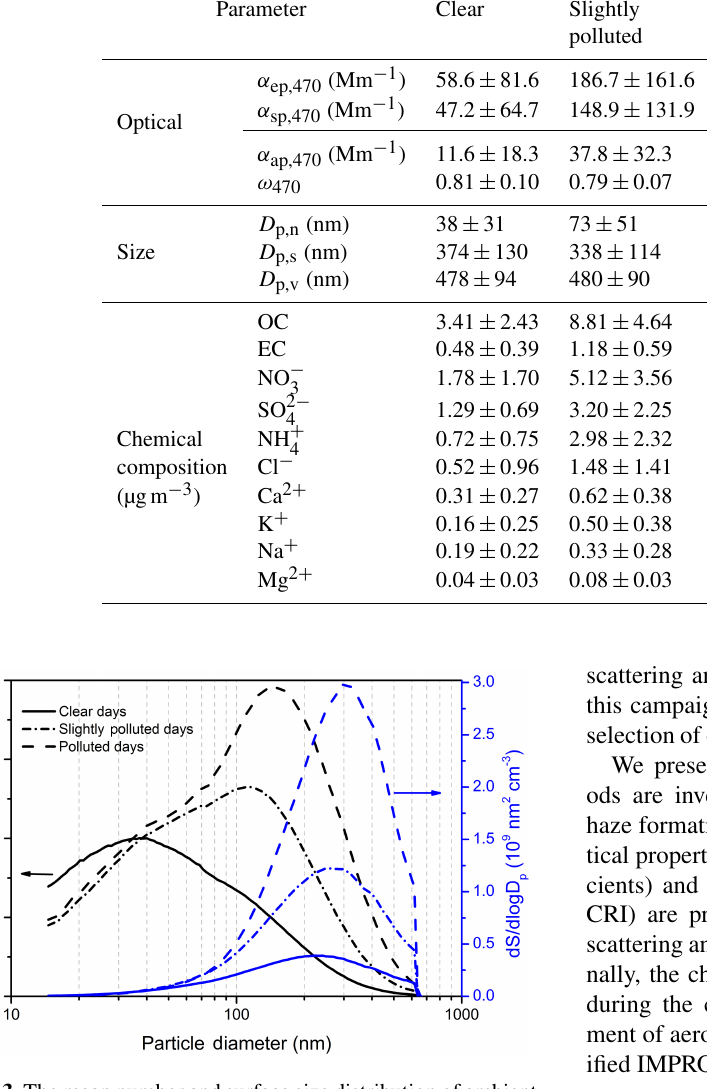
Figure 3. The mean number and surface size distribution of ambient aerosol on clear, slightly polluted, and polluted